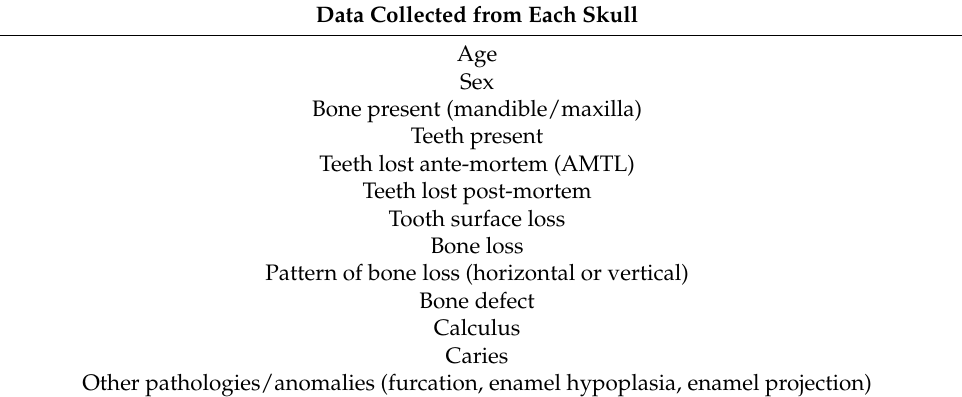
Table 1. Data collected for the study.